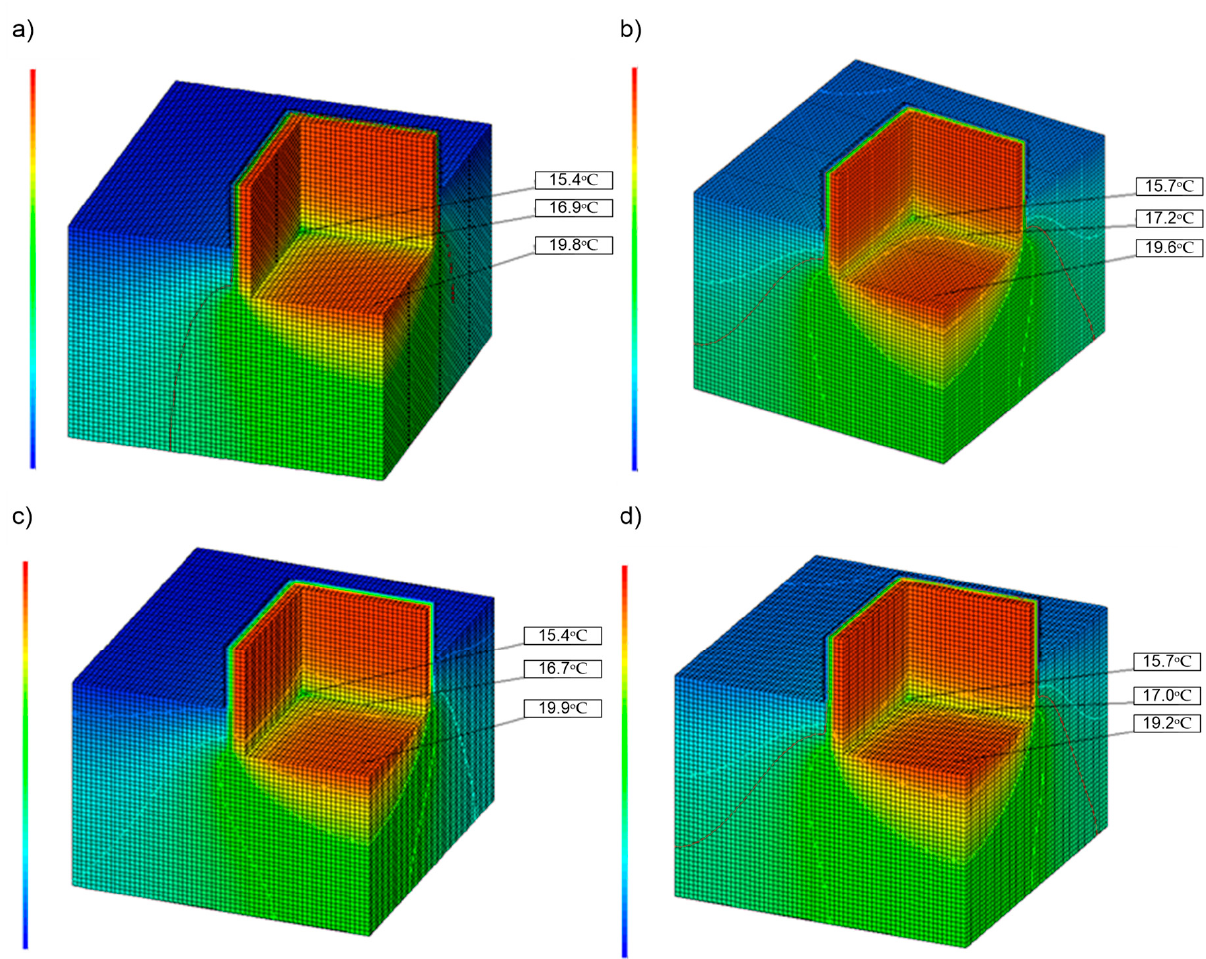
Figure 11. Temperature field changes for a 3D node of the foundation–wall connection with a slab: ( a ) model W_2, ( b ) model W_2a for Profile I; and ( c ) model W_3, ( d ) model W_3a for Profile II.